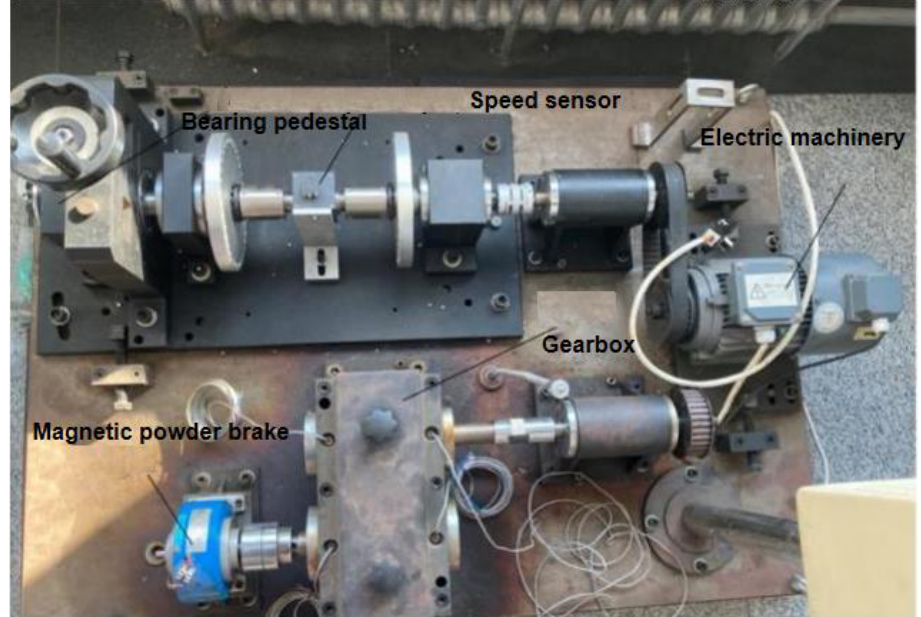
Figure 11. Test bench for rolling bearing fault diagnosis.